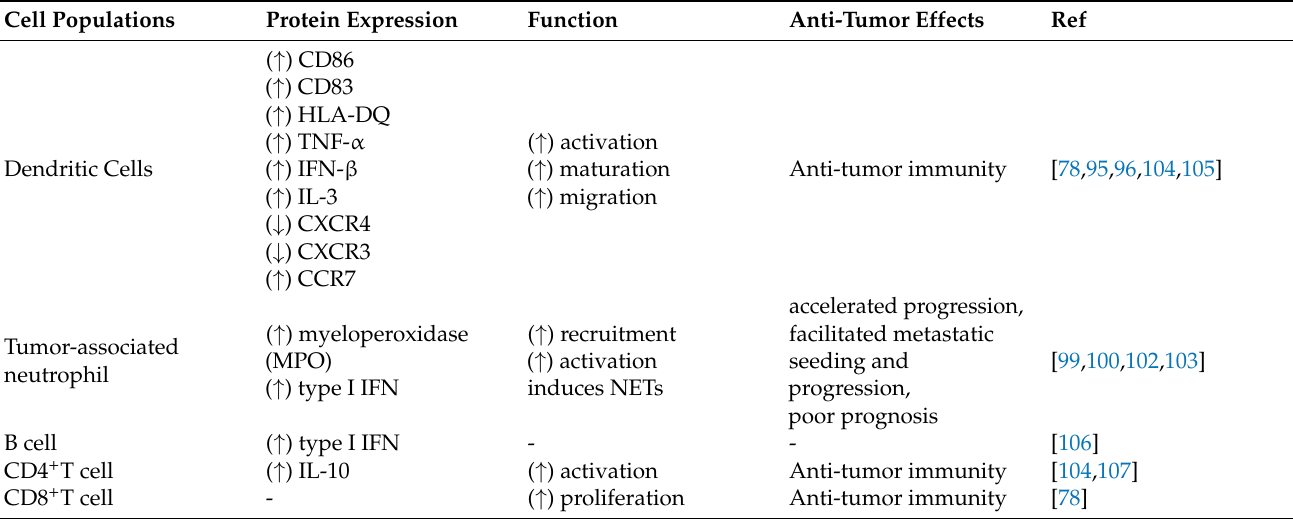
Table 2. Effects of mtDNA on different immune cell